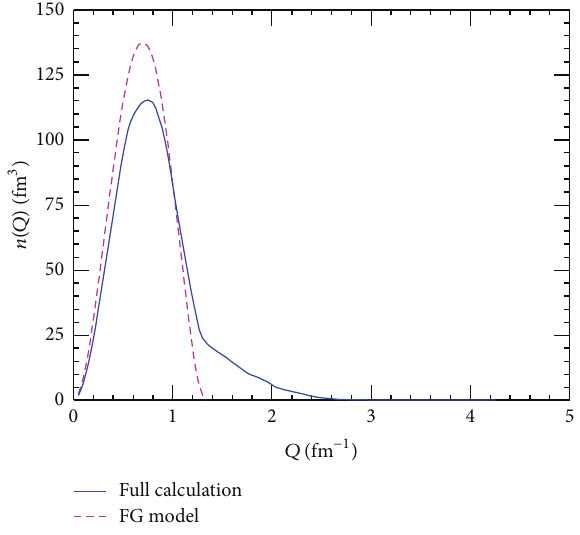
Figure 8: Comparison between the two-nucleon relative momen- tum distribution of nuclear matter computed within nuclear many- body theory using a realistic hamiltonian (solid line) [49], and the prediction of the Fermi gas (FG) model (dashed